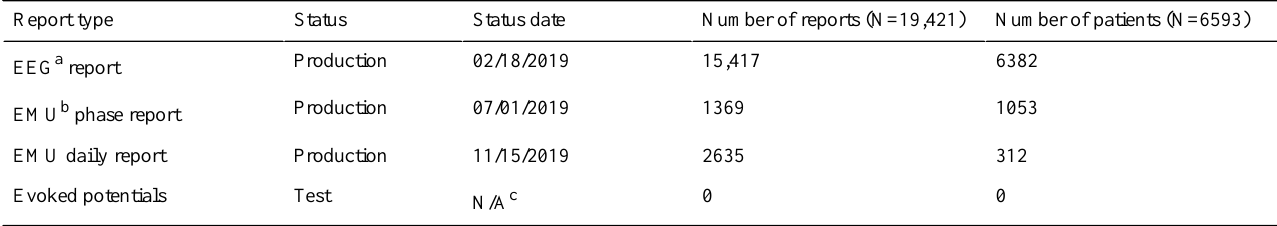
Table 2. EpiToMe report statistics.